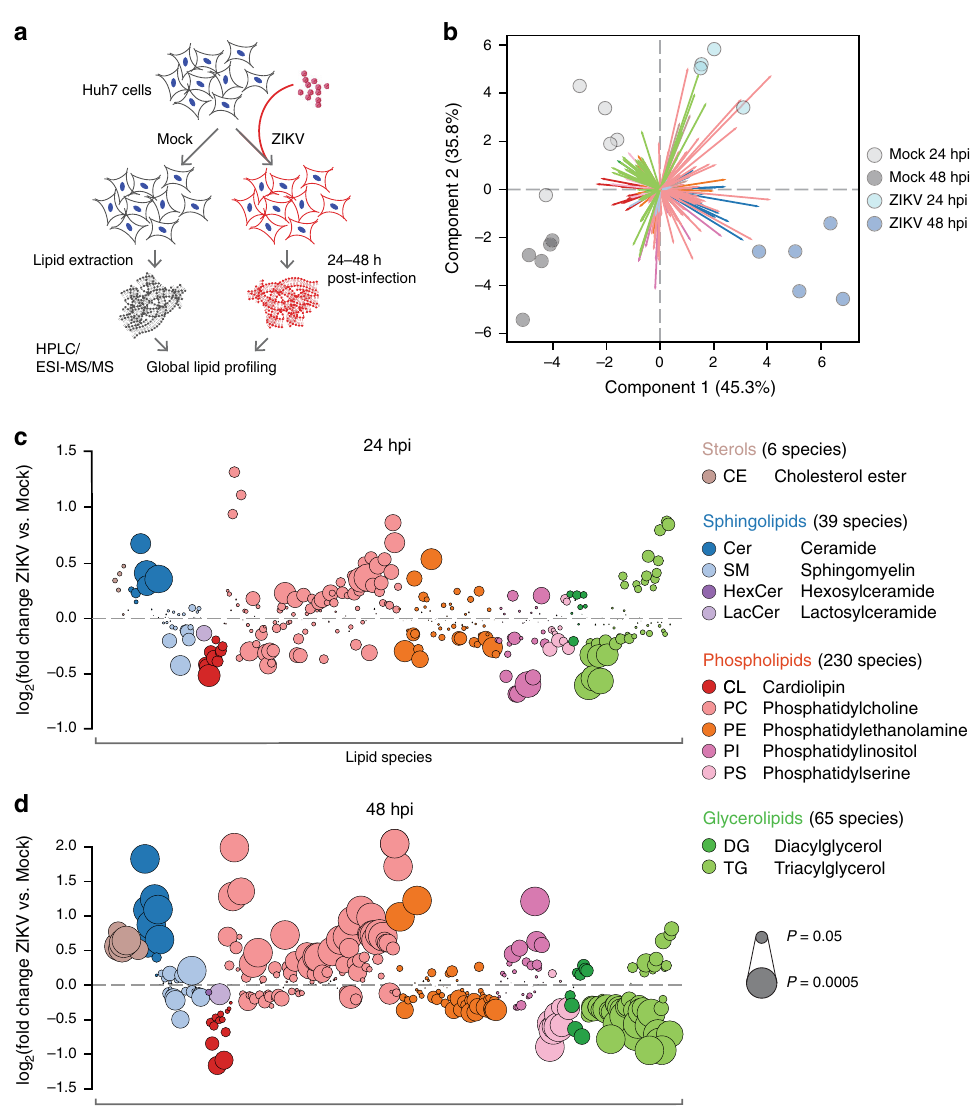
Fig. 1 Global lipidomics of ZIKV-infected human cells. a Study overview. Huh7 cells were infected with ZIKV strain FSS13025 for 24 or 48 h. Each experimental condition (Mock 24 hpi, ZIKV 24 hpi, Mock 48 hpi, and ZIKV 48 hpi) had n = 5 replicates for a total of 20 biological samples, 19 of which were included in our fi nal analysis. b Principal component analysis (PCA) of the lipidomics dataset. Colored arrows represent individual lipid species. c , d Bubble plots of log2 fold changes in abundance of lipid species in ZIKV-infected cells relative to mock at 24 hpi ( c ) and 48 hpi ( d ). Bubble size represents P value from one-way ANOVA or g test. See also Supplementary Fig. 1, Supplementary Data 1, and the Source Data fi